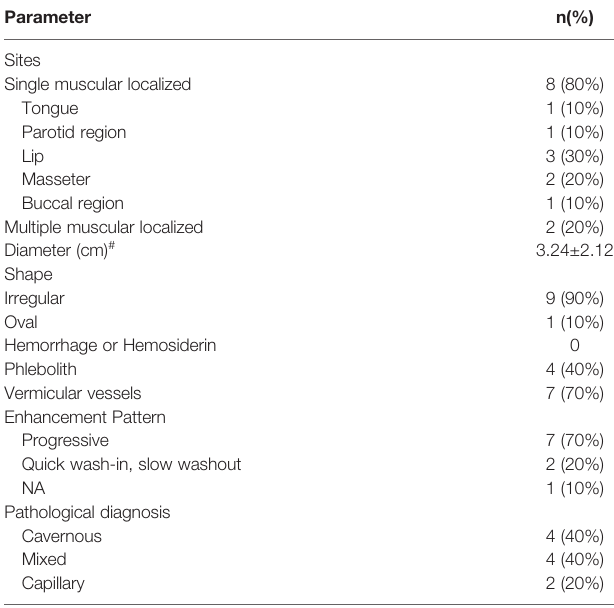
TABLE 2 | Preoperative CT fi ndings of 10 patients with intramuscular hemangiomas. Parameter n(%) Sites Single muscular localized